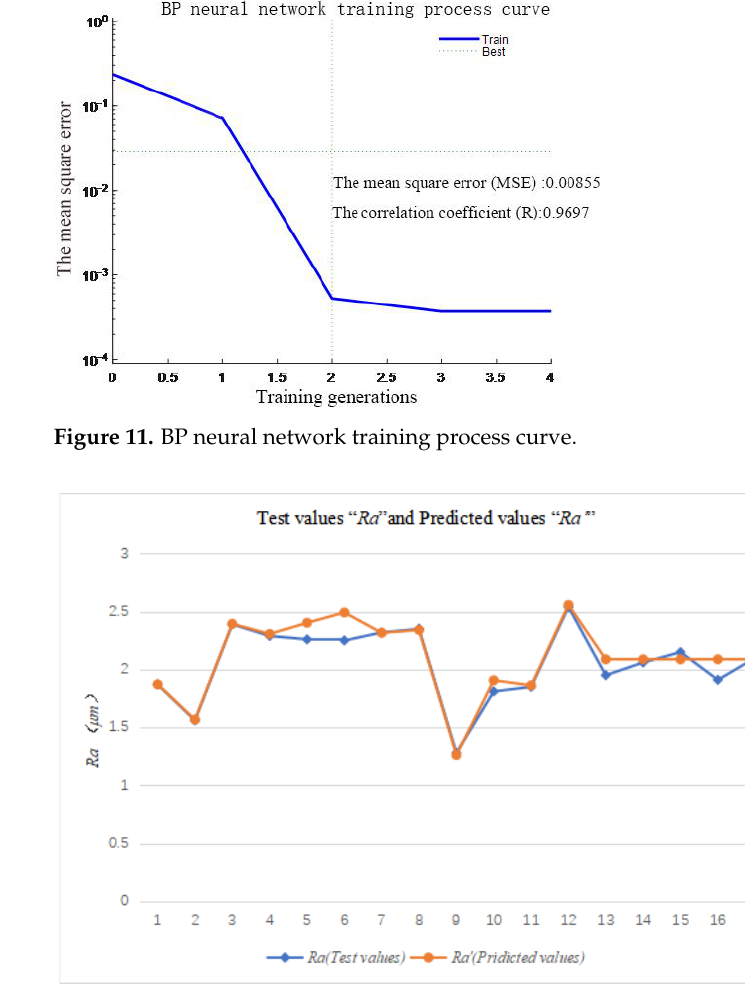
Figure 12. Test values compared with the predictions.